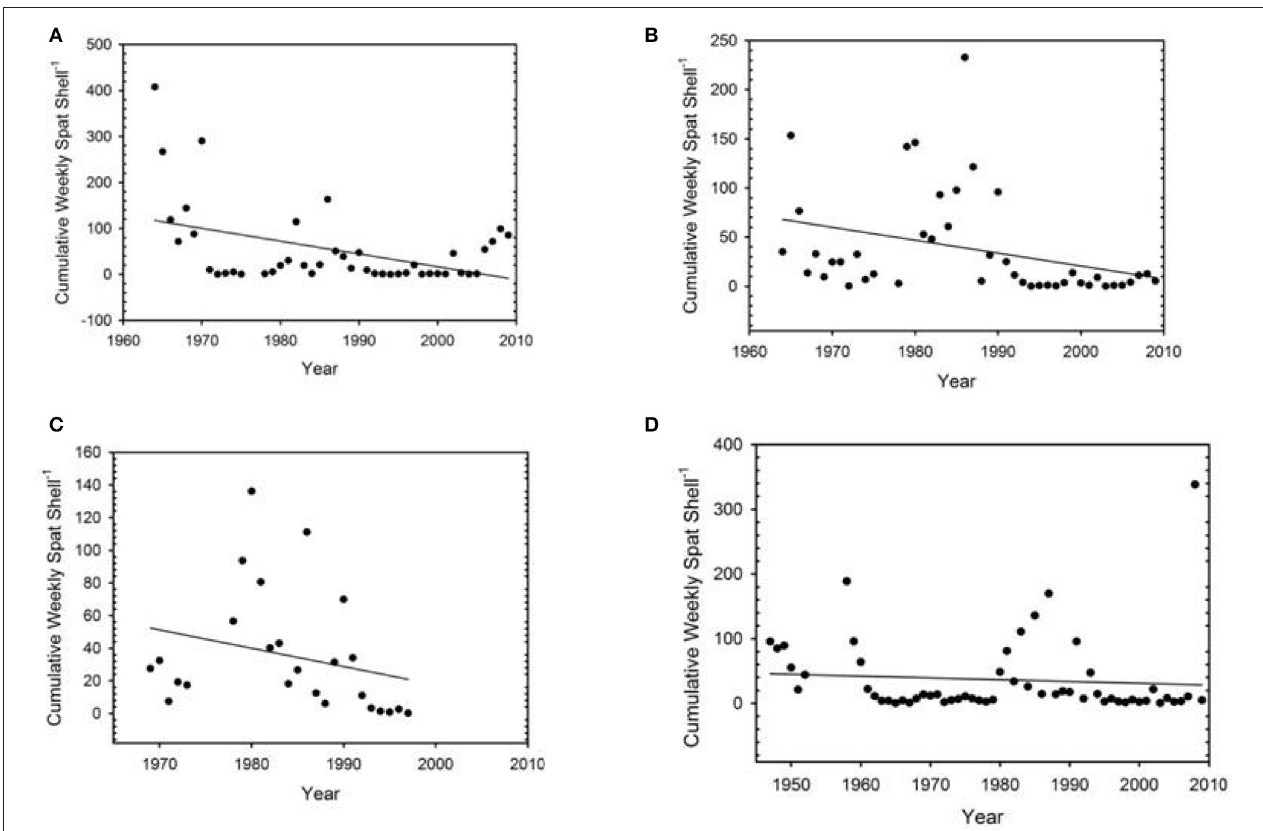
FIGURE 4 | Mean spatfall over time in various Virginia tributary rivers over time. (A) Great Wicomico River, (B) Piankatank River, (C) Mobjack Bay, and (D) James